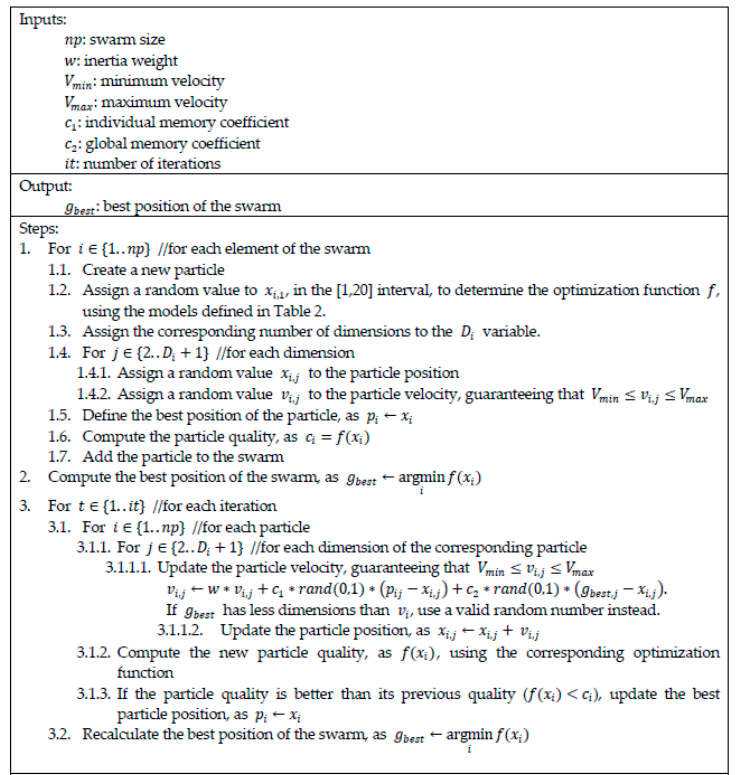
Figure 3. Pseudocode of the modified PSO algorithm.